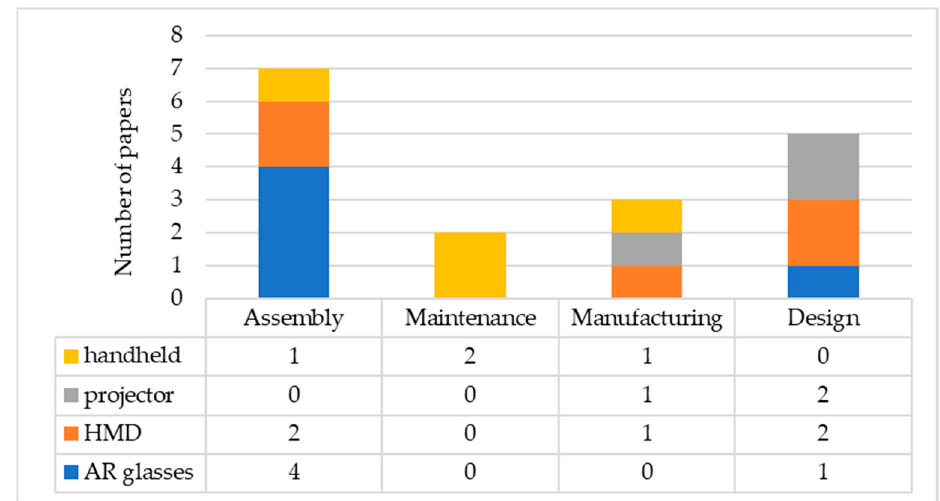
Figure 14. Distribution of display devices used in the selected papers according to the application field.